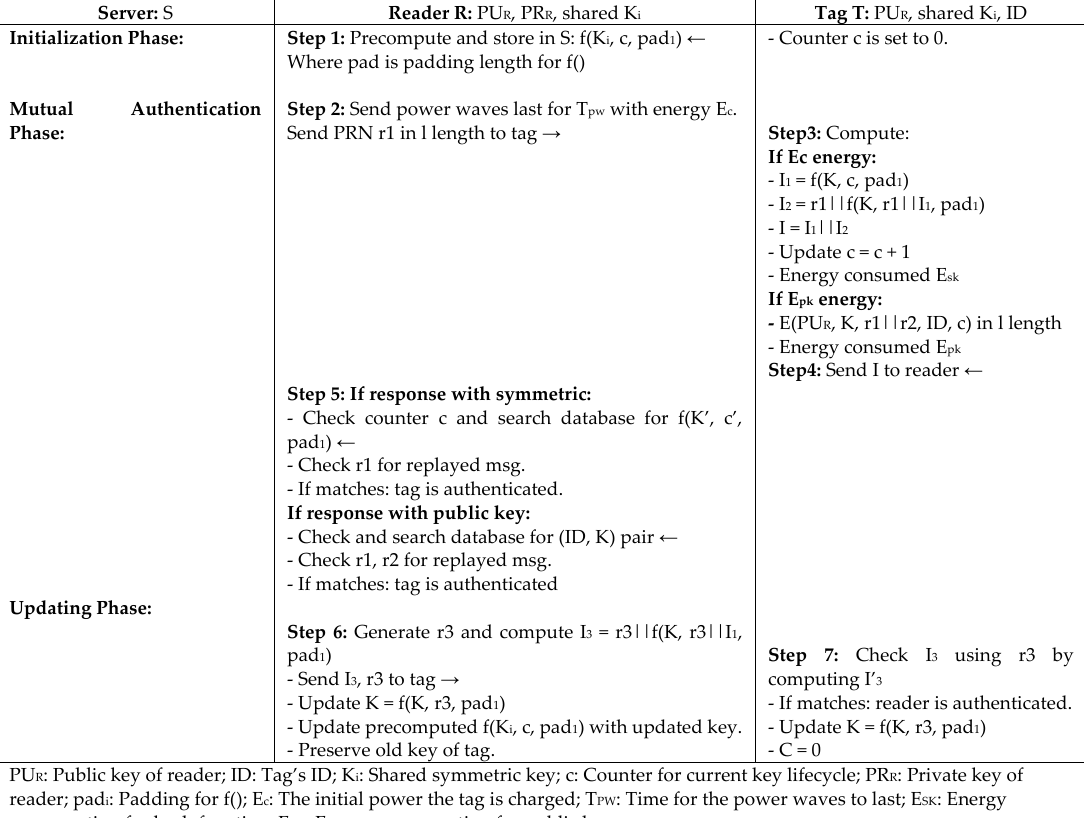
Figure 5. The Reviving-UNder-Denial of Service Authentication Protocol (RUND) by Yao.